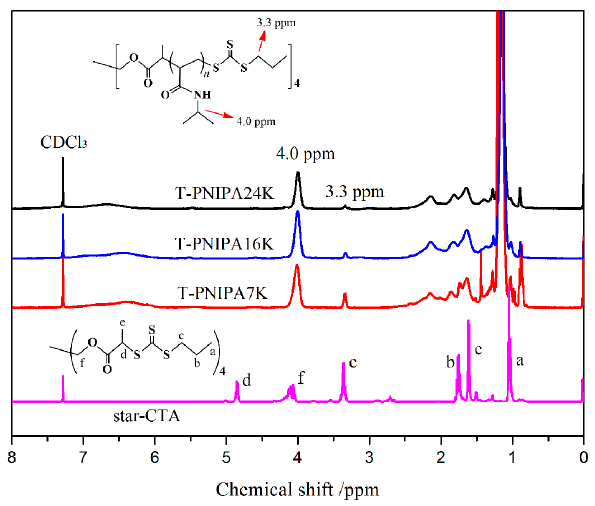
Figure 2. 1 H NMR spectra of star-CTA and T-PNIPAs with terminal trithiocarbonate groups.